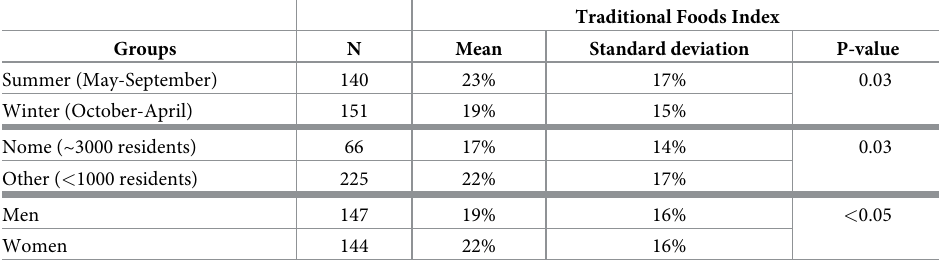
Table 2. Traditional eating by season, community size, and gender.